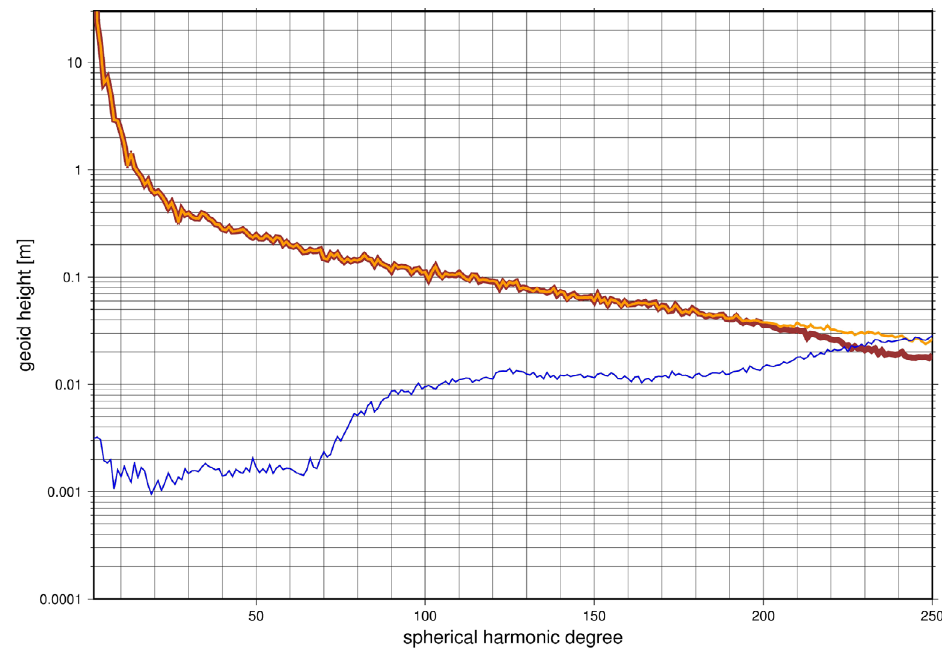
Figure 4. Spectral characteristics of the EGM2008 and NULP-02S ( ––– NULP-02S, ––– EGM2008, ––– differences between EGM2008 and